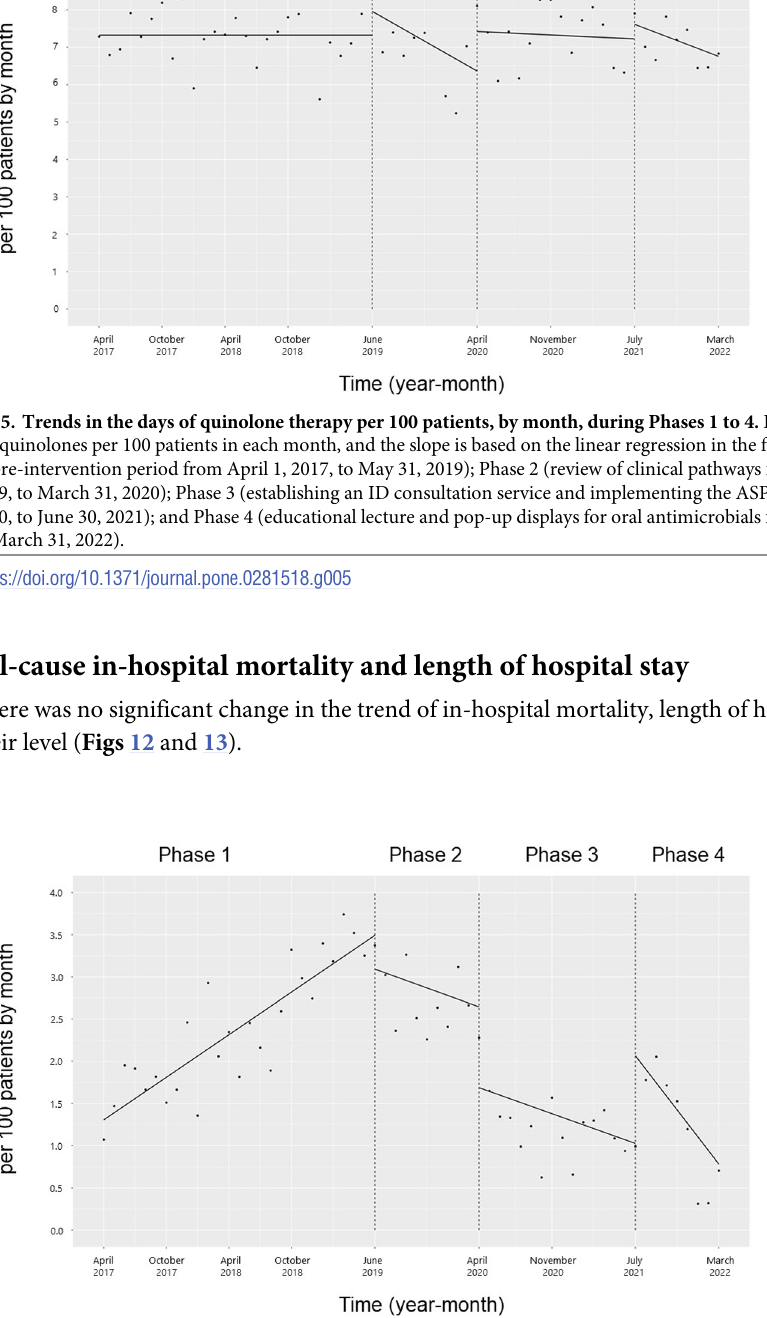
Fig 6. Trends in the days of macrolides therapy per 100 patients, by month, during Phases 1 to 4. Each dot refers to the macrolides per 100 patients each month, and the slope is based on the linear regression in the four phases: Phase 1 (pre-intervention period from April 1, 2017, to May 31, 2019); Phase 2 (review of clinical pathways from June 1, 2019, to March 31, 2020); Phase 3 (establishing an ID consultation service and implementing the ASP from April 1, 2020, to June 30, 2021); and Phase 4 (educational lecture and pop-up displays for oral antimicrobials from July 1, 2021, to March 31,